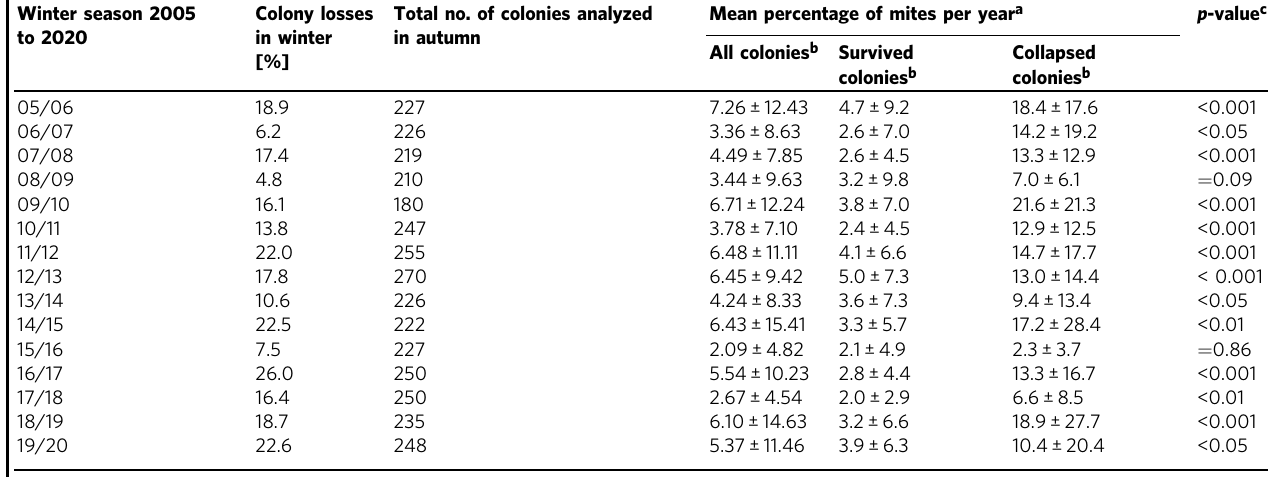
Table 1 Data on V. destructor infestation levels in autumn in colonies that survived or collapsed during the winter seasons over the entire study period from autumn 2005 until spring